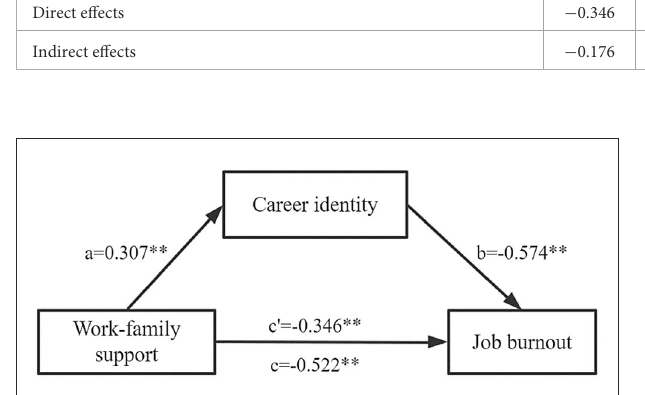
FIGURE1 Schematic representation of the mediating effect of career identity between work-family support and burnout. a , b : mediating effect